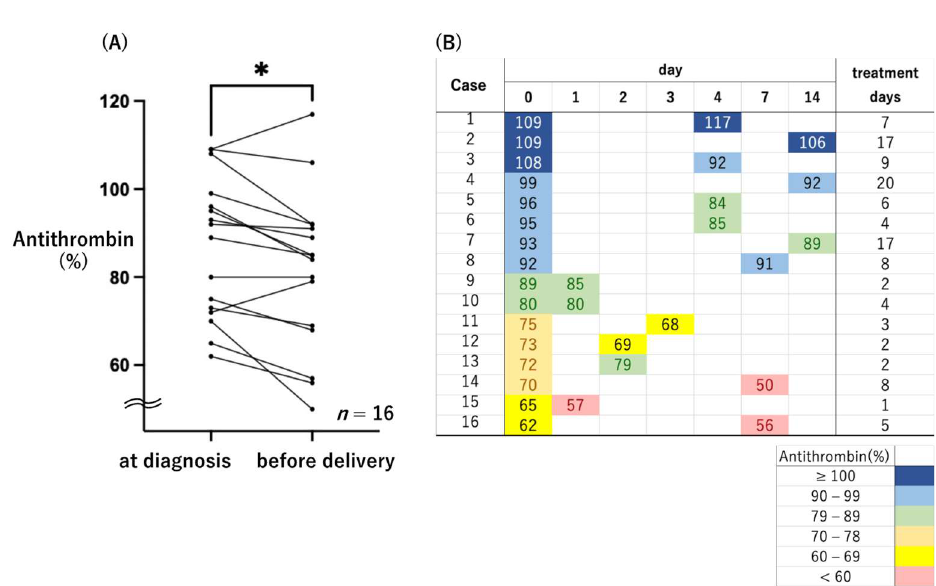
Figure 1. Plasma antithrombin activity in the MgSO 4 nontreatment group. ( A ) Plasma antithrombin activity at diagnosis and just before delivery. * p = 0.015 ( B ) Transition of plasma antithrombin activity from diagnosis to delivery. Treatment days means number of days from diagnosis to delivery. The degree of antithrombin activity was identified by the six colors shown in this figure (Navy: ≥ 100%; Blue: 90–99%; Green: 79–89%; Orange: 70–78%; Yellow: 60–69%; Red: <60%).